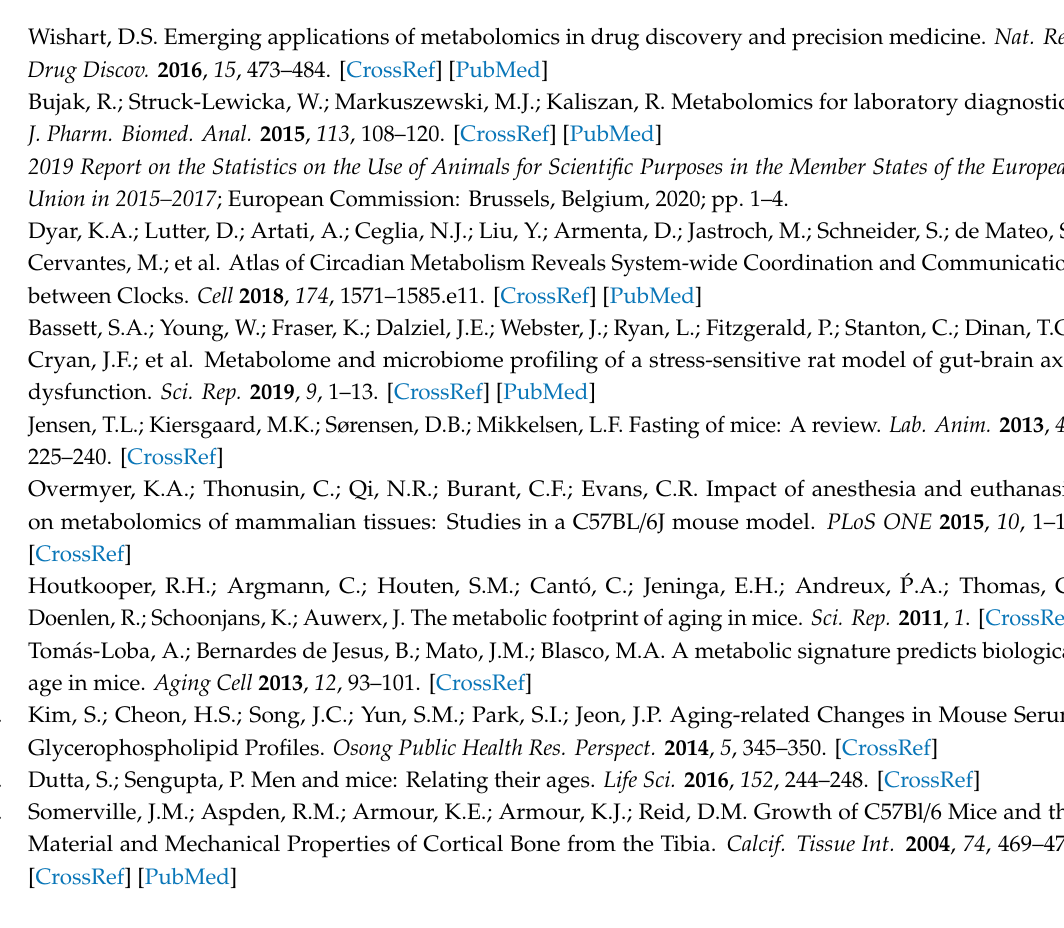
Figure S1: Age-dependent changes of C5-carnitine levels in female and male mice, Figure S2: Body weight development of di ff erent mouse strains, Table S1: Selected PCA loading scores for age-dependent metabolomic changes in female mice, Table S2: Selected PCA loading scores for age-dependent metabolomic changes in male mice, Table S3: Selected PCA loading scores for females of age-matched mouse strains, Table S4: Selected PCA loading scores for males of age-matched mouse strains. Table S5: Fold changes of selected metabolites showing overlap in age regulation among female mice of di ff erent strains, Table S6: Fold changes of selected metabolites showing overlap in age regulation among male mice of di ff erent